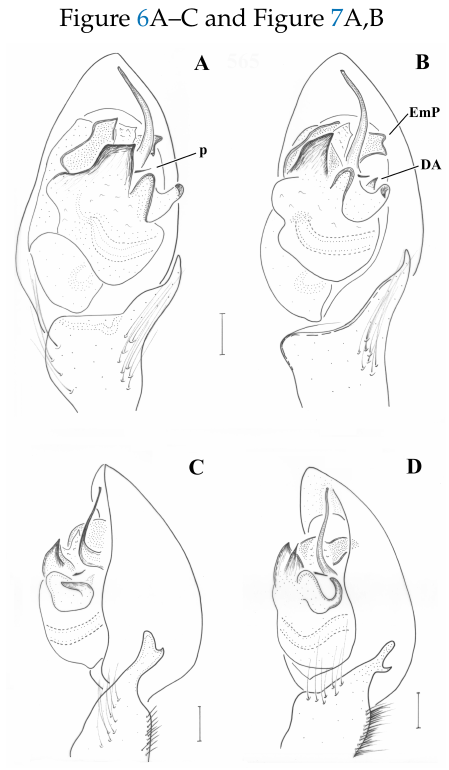
Figure 6. Drassyllus centrohellenicus n.sp. and Drassyllus dadianus n.sp. (holotypes), male pedipalps. ( A ) D. centrohellenicus n.sp., ventral view, ( B ) same, ventral to retrolateral view, ( C ) same, retrolateral view, ( D ) D. dadianus n.sp., retrolateral view. p: transverse projection, EmP: embolar projection, DA: dorsal